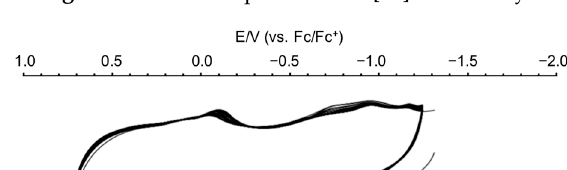
Figure 2. Schematic picture of Li-[28]hex battery.